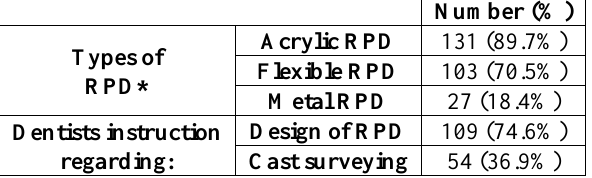
Table 8: Types of removable partial dentures constructed and the dentist’s instruction regarding RPDs design given to the